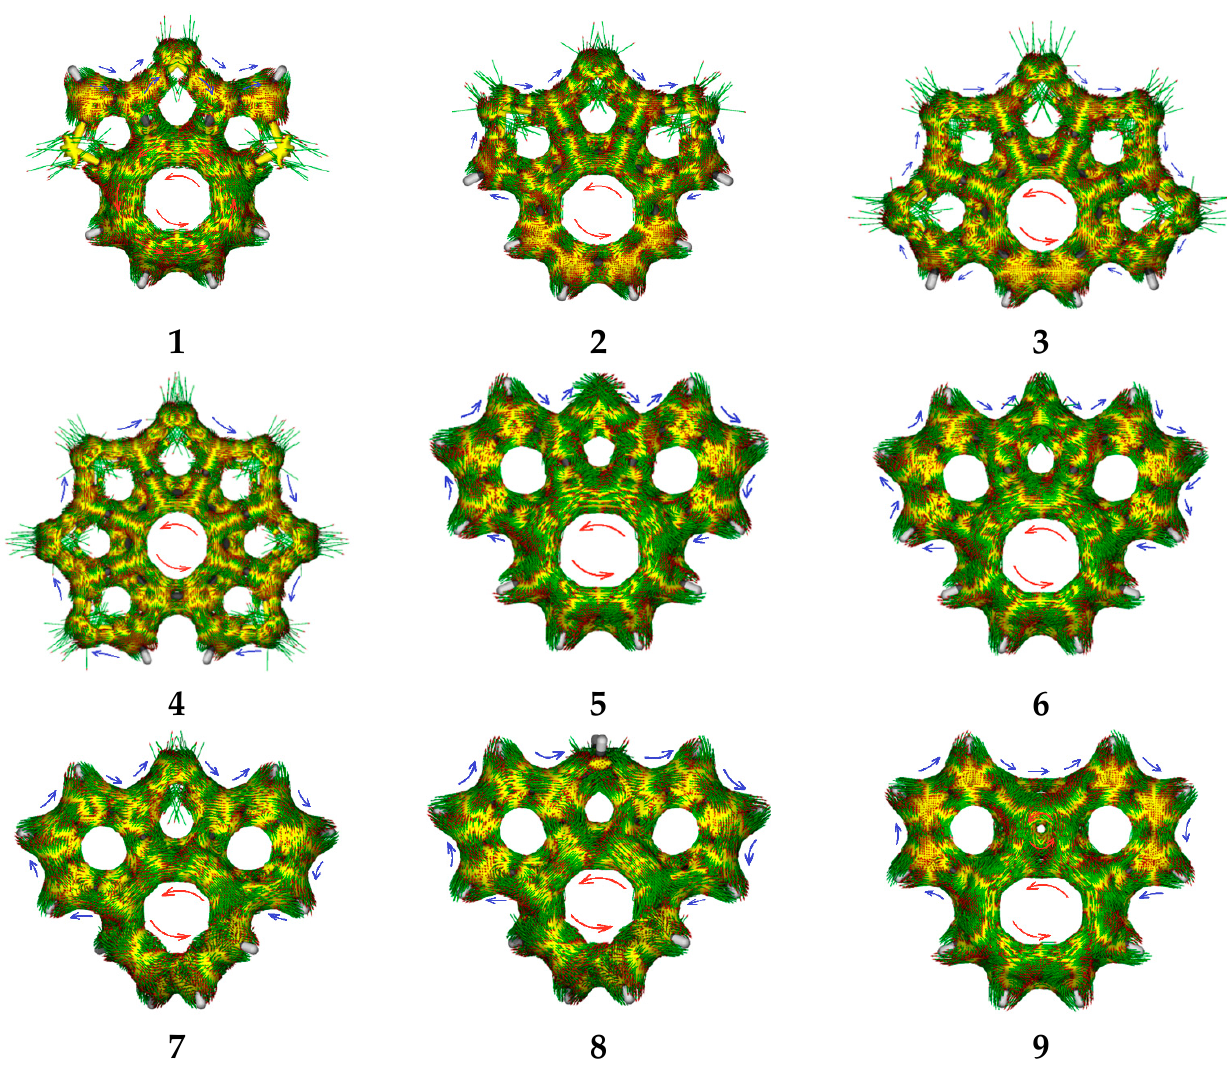
Figure 5. ACID plots. Blue arrows—local diatropic currents, red arrows—paratropic currents.